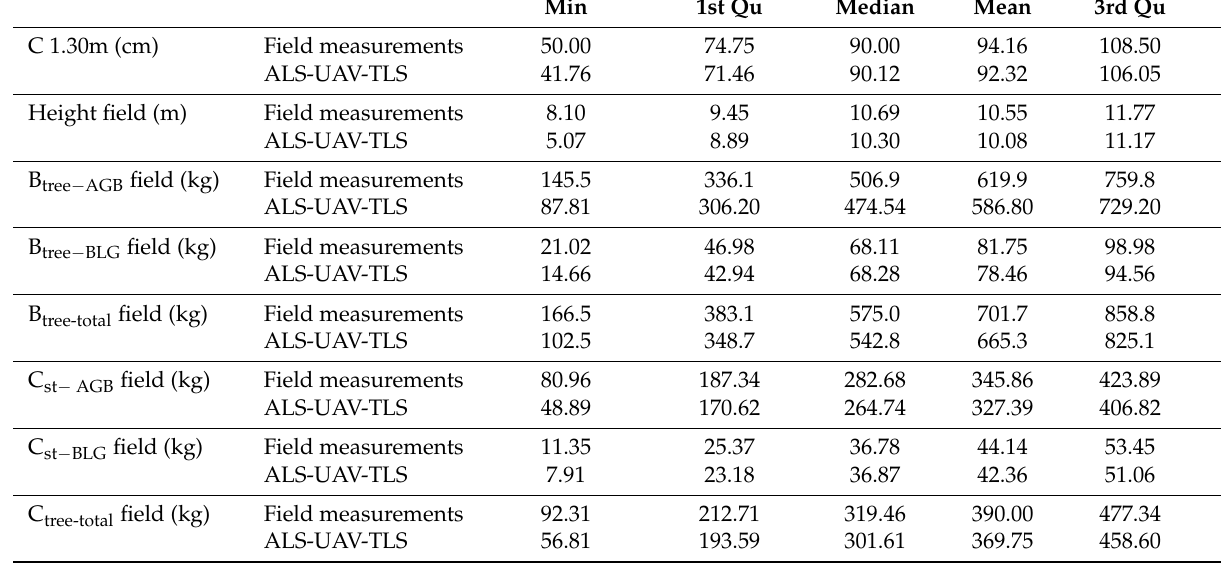
Table 3. Descriptive statistics of dendrometric parameters (H, C 1.30m ), biomass, and carbon stock (aboveground, belowground, and total) measured and estimated with field data collection and from UAV-ALS-TLS data. Where, B tree − AGB is the tree aboveground biomass (in kg), B tree-BLG is the belowground biomass of an individual tree in kg, B tree − Total is the total biomass of an individual tree in kg, C st-AGB is the aboveground carbon stock (in kg), C st-BLG is the carbon stock in the belowground tissues, and C st-total is the total carbon stock content of an individual tree in kg. Min